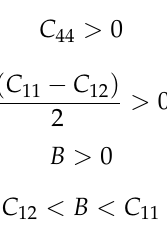
Table 3. Calculated elastic constants C ij , bulk modulus B , shear modulus G , Young’s modulus E (GPa), Pugh’s ratio B / G , anisotropy factor A , and formation and cohesive energies (eV) for the stoichiometric quaternary Heusler (SQH) compounds ZrRhTiAl and ZrRhTiGa.